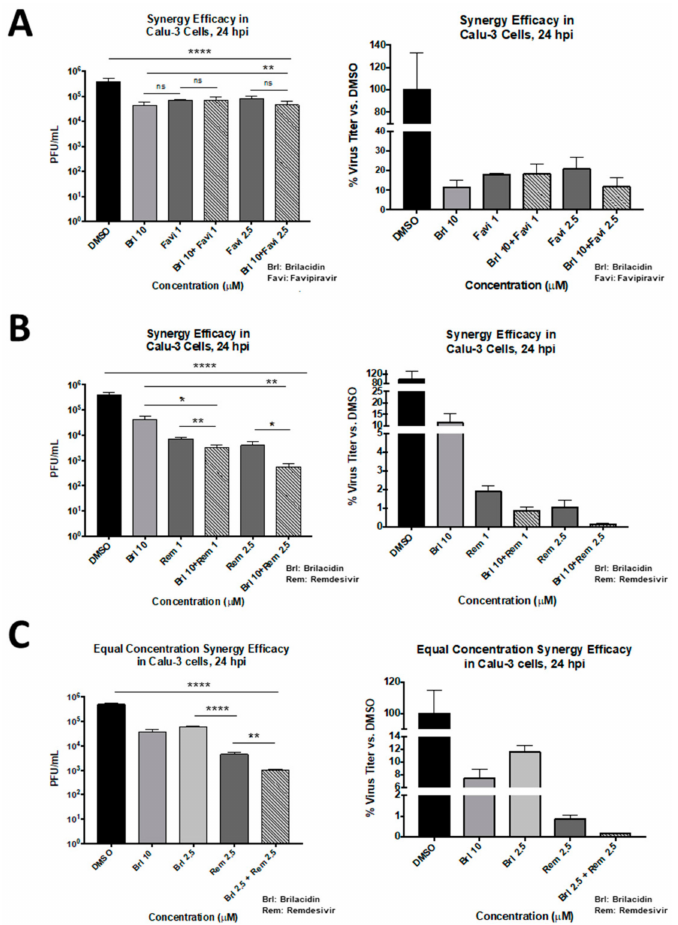
Figure 5. Efficacy of brilacidin as a combinatorial strategy as assessed in Calu-3 cells. Calu-3 cells were pretreated for 2 h with media alone or media containing brilacidin at 10 µ M (for synergy treatments). ( A ) Cells were infected with SARS-CoV-2 at MOI 0.05 directly with brilacidin at 10 µ M (for synergy treatments) or SARS-CoV-2 incubated in media alone (for favipiravir treatment alone). After 1 h, post-treatment with favipiravir alone or mixed with 10 µ M brilacidin were added to cells at 1 or 2.5 µ M concentrations. At 24 hpi, viral supernatants were evaluated by plaque assay as described in Materials and Methods. Calu-3 cells were pretreated for 2 h with media alone or media containing brilacidin at 10 or 2.5 µ M (for synergy treatments). Cells were infected with SARS-CoV-2 at MOI 0.05 directly with brilacidin at 10 or 2.5 µ M (for synergy treatments) or SARS-CoV-2 incubated in media alone (for remdesivir treatment alone). After 1 h, post-treatment with remdesivir alone, or mixed with 10 µ M ( B ) or 2.5 µ M ( C ) brilacidin, were added to cells at 1 or 2.5 µ M concentrations. At 24 hpi, viral supernatants were evaluated by plaque assay as described in Materials and Methods. Graphs are representative of one independent experiment performed in technical triplicates ( n = 3). Brl indicates brilacidin, Rem indicates remdesivir. Statistical analyses for synergy vs. individual control treatments were determined using Unpaired Two-Tailed Student’s t test. Significance against DMSO was determined as described in Materials and Methods. * p < 0.0332, ** p < 0.0021, **** p <